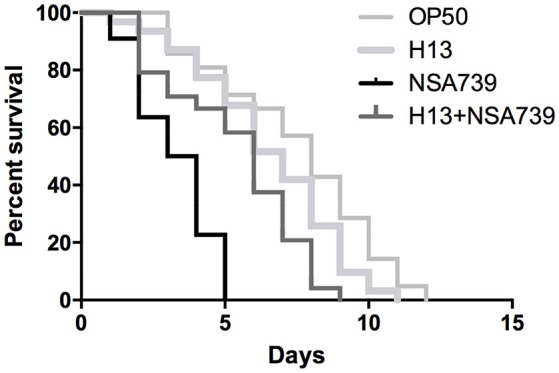
In vivo kinetics of killing of C. elegans infected by S. aureus NSA739, H. kunzii H13, and co-infected by the two strains. OP50 represents the survival curve for worms fed on non-pathogenic E. coli. In all cases, worms were grown on NGM plates at 25°C and ≈ 30 Fer-15 were used in each test. The curves are representative of at least three independent trials for each group of strains.